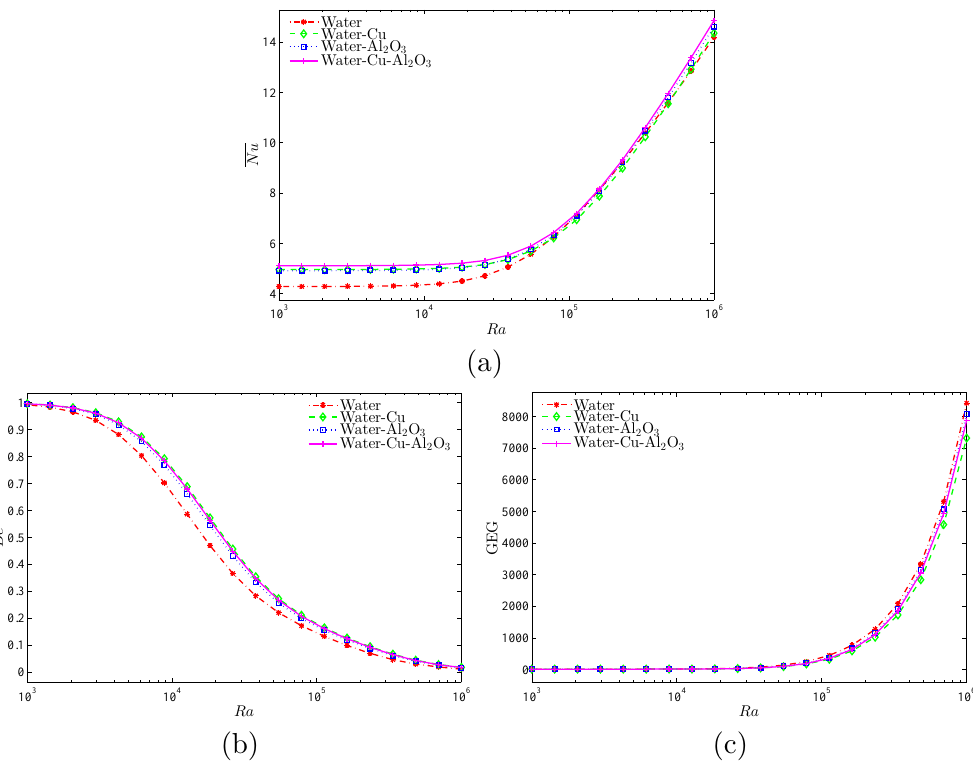
Figure 9. The evolution of the average characteristic as a function Rayleigh number Ra for the base fluid, nanofluids, and hybrid nanofluids: ( a ) average Nusselt number ( Nu ), ( b ) Bejan number ( Be ), and ( c ) the global entropy generation (GEG) when φ = 0.02 and D =